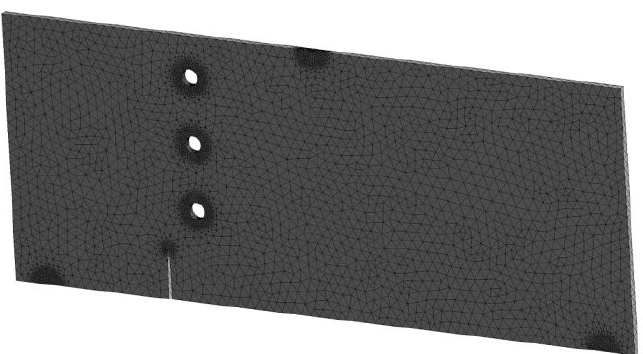
Figure 2. Initial mesh for the three-point bending beam.